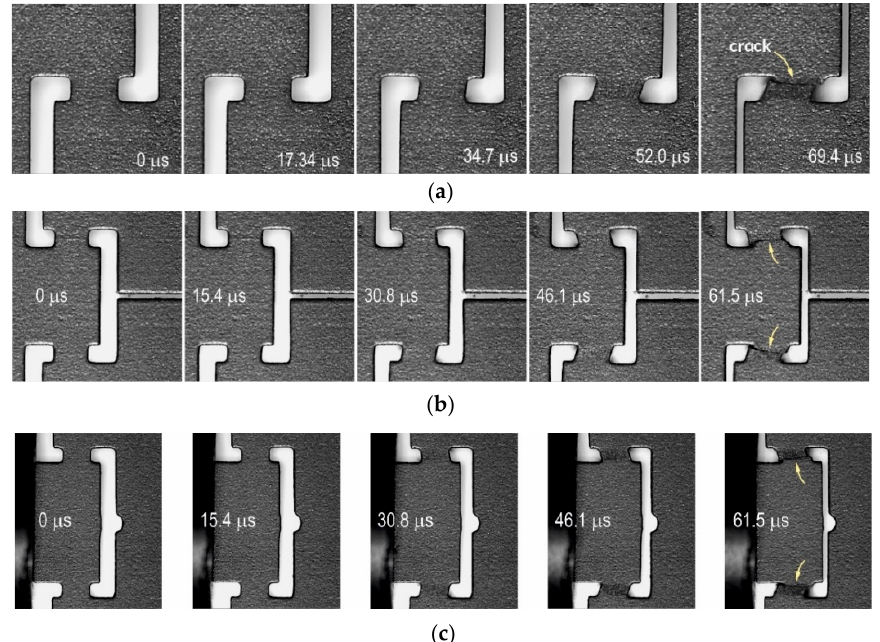
Figure 5. The deformation process of the tested shear specimens captured by high-speed camera: ( a ) SSS specimen; ( b ) DSS specimen; ( c ) D2S specimen (arrows indicate where the cracks appear).